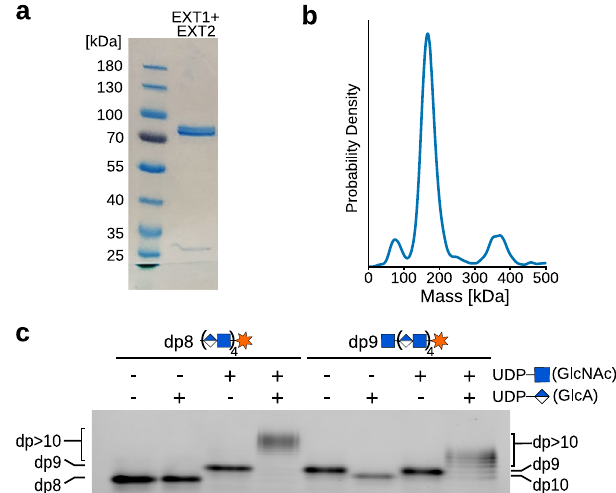
Fig. 1 | Puri fi cation and functionalcharacterizationoftheEXT1-EXT2complex. a Coomassie-stainedSDS-PAGEanalysisofpuri fi edEXT1-EXT2complex,lackingthe N-terminalmembraneanchoringhelix.Expectedmolecularsizesof EXT1and EXT2 areabout85kDaand79kDa,respectively.SourcedataisprovidedasaSourceData 1. b Mass photometry analysis of puri fi ed complex with a major peak at 160kDa. SourcedataisprovidedasaSourceData2. c ThecatalyticactivityofEXT1-EXT2was studied using an in vitro glycosylation assay. The speci fi c transfer of N -acet- ylglucosamine (GlcNAc) and glucuronic acid (GlcA) molecules was followed using synthetic, fl uorescently-labeled octa-saccharide (dp8) and nona-saccharide (dp9) substrate analogs. Source data is provided as a Source Data